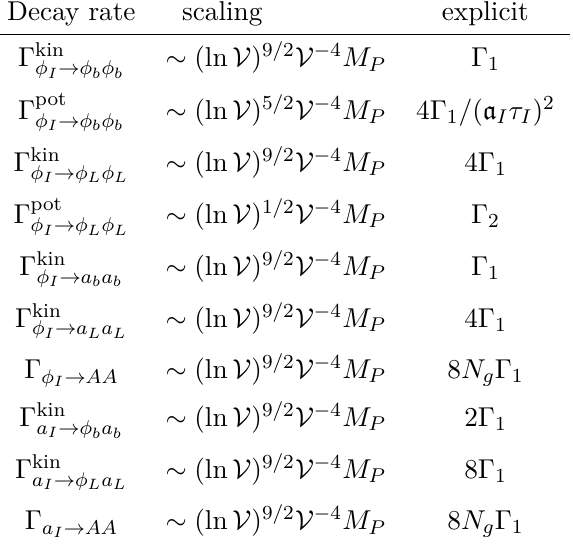
Table 2 . Decay rates of inflaton into moduli and axion fields. The explicit decay rates are